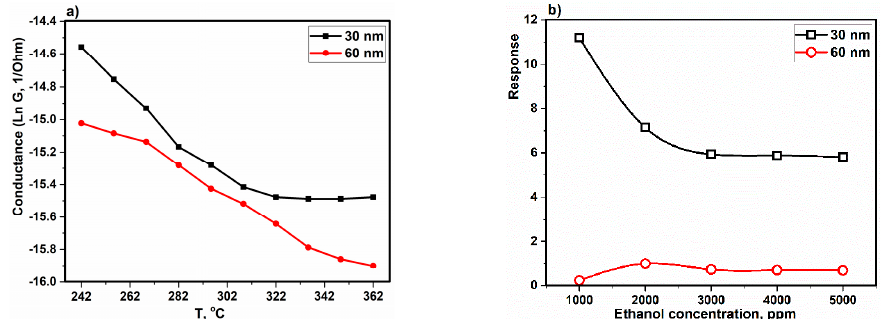
Figure 10. ( a ) Arrhenius curves of sensors with composite layers of thickness of 30 and 60 nm and ( b ) sensitivity of the devices based on ethanol concentrations. ( b ) sensitivity of the devices based on ethanol